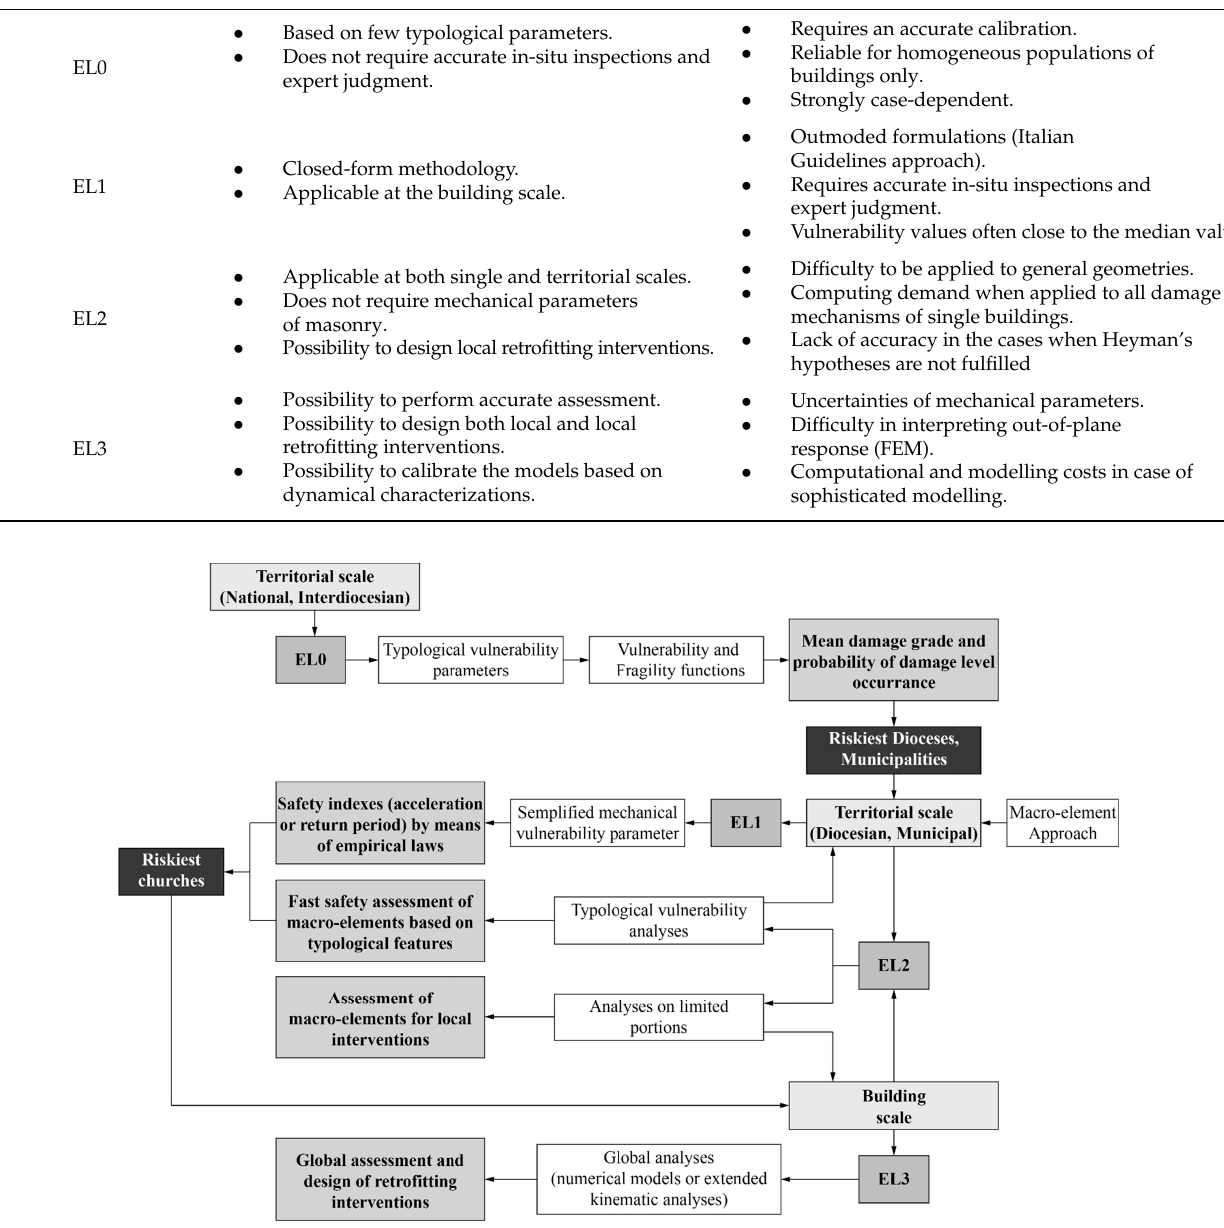
Figure 7. Potential management policy for a smart decision-making process of masonry church assets.